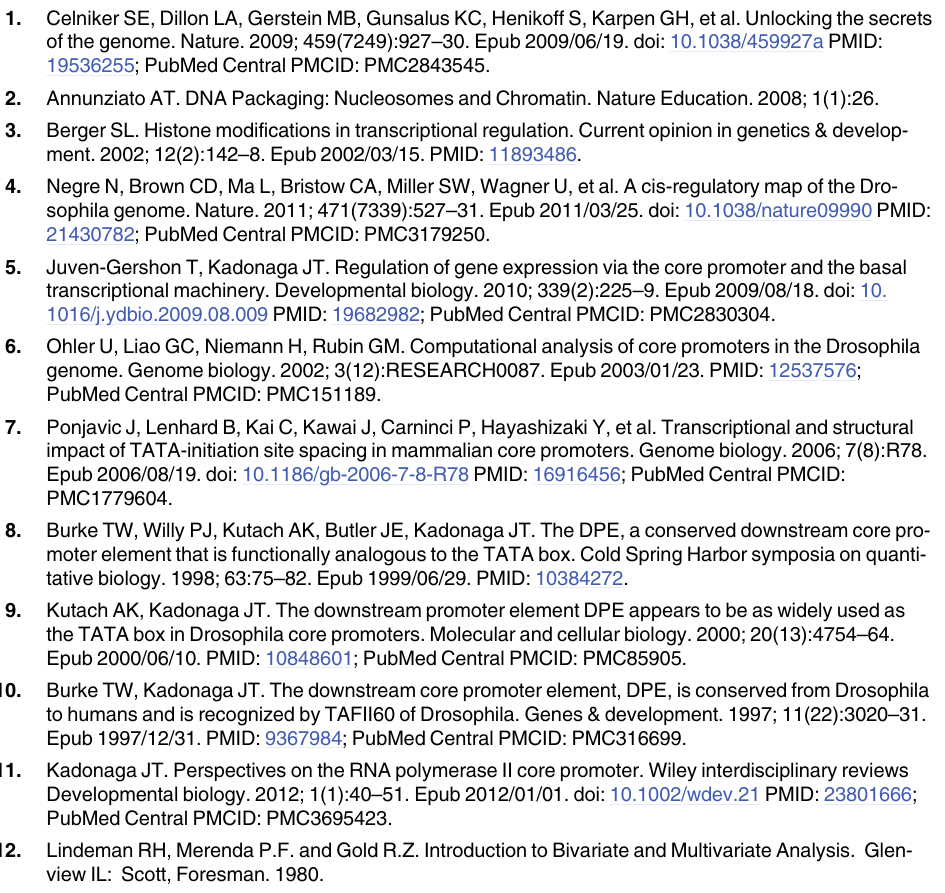
S8 Fig. Clustering analysis of histone modification ratios in each CPE group. The k-means clustering was performed with 1000 iteration to obtain five clusters for each CPE group. The distribution of the histone modification ratios in each cluster was visualized by boxplot. The y- axis represents the histone modification ratio, and the x-axis represents the histone modifica- tion. The clusters were sorted from top to bottom according to their numbers of core promot- ers. Bold lines represent clusters in which the medians of histone modifications were equal to